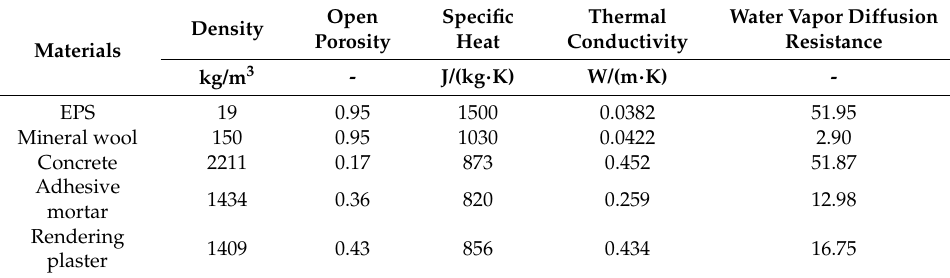
Table 1. Basic physical properties of